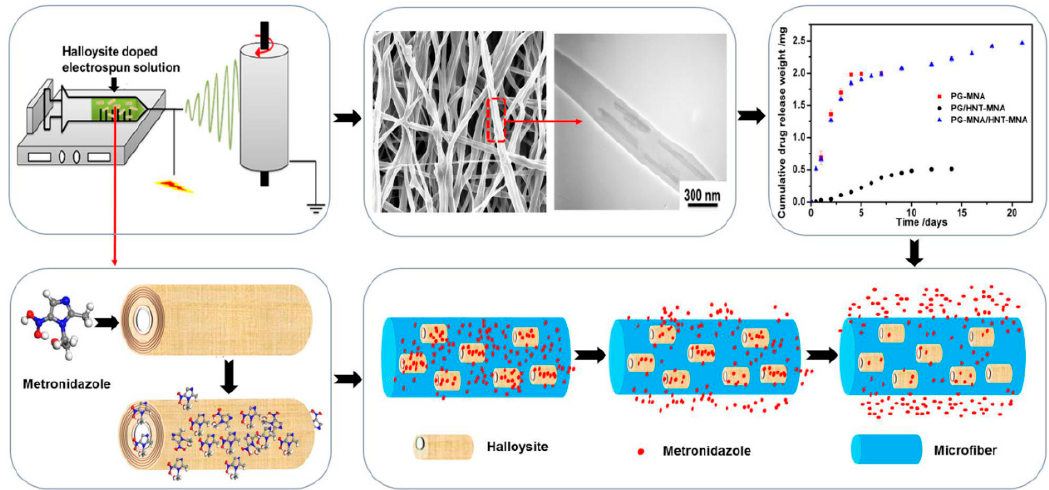
Figure 8. Electrospinning drug-loaded halloysite clay nanotubes doped into